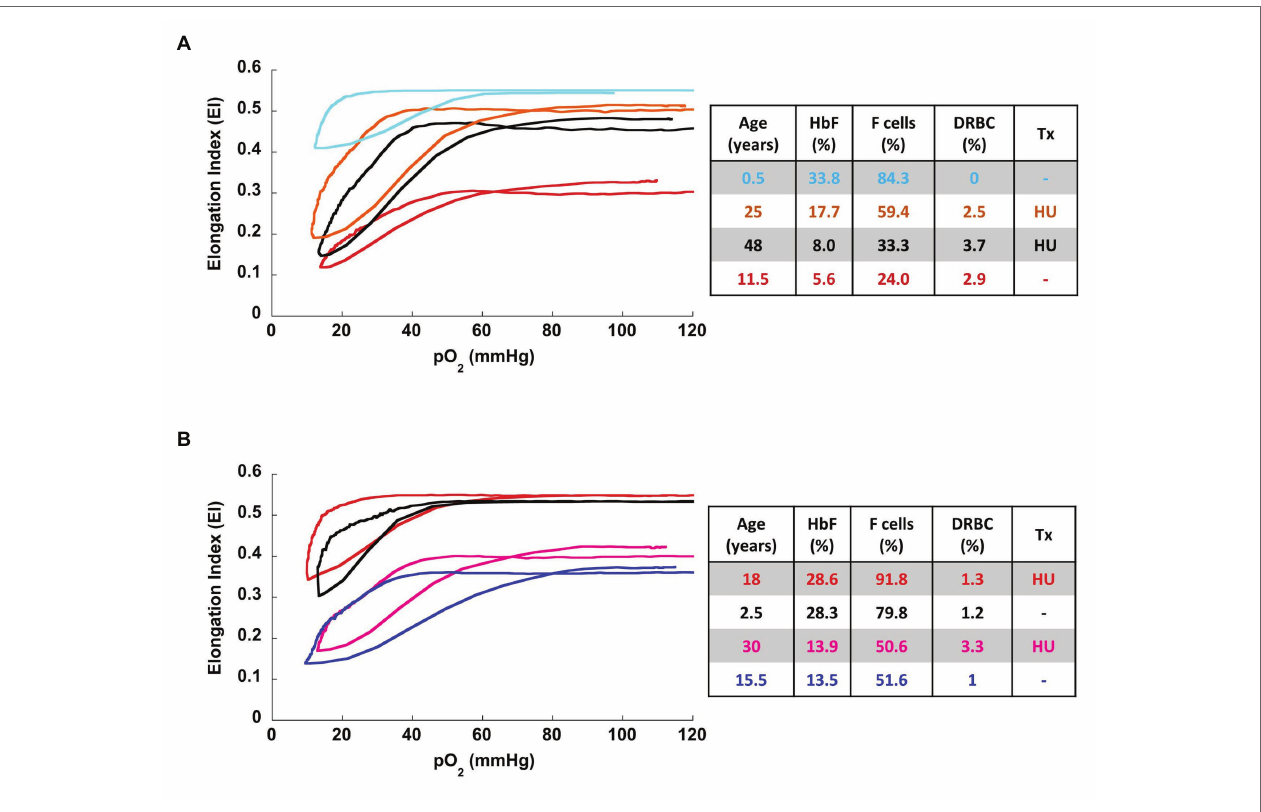
FIGURE 3 | Representative oxygenscan curves. (A) Four patients with sickle cell disease with corresponding parameters of %HbF, %F-cells, and %DRBCs. In general, increase fetal hemoglobin content (%HbF and %F-cells) and decrease in %DRBC are associated with increase in EI max and EI min and a decrease in PoS. The oxygenscan profile appears to be affected by the combination of these parameters. (B) Two pairs of patients with similar HbF, with and without hydroxyurea therapy. At both high HbF (top pair of curves) and low HbF (bottom pair of curves) hydroxyurea is associated with higher EI max and EI min . HU, hydroxyurea; Tx,